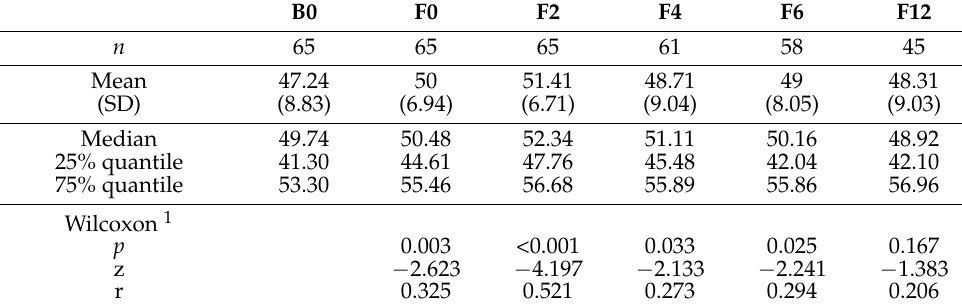
Table 3. Development of PCS, using Wilcoxon signed-rank